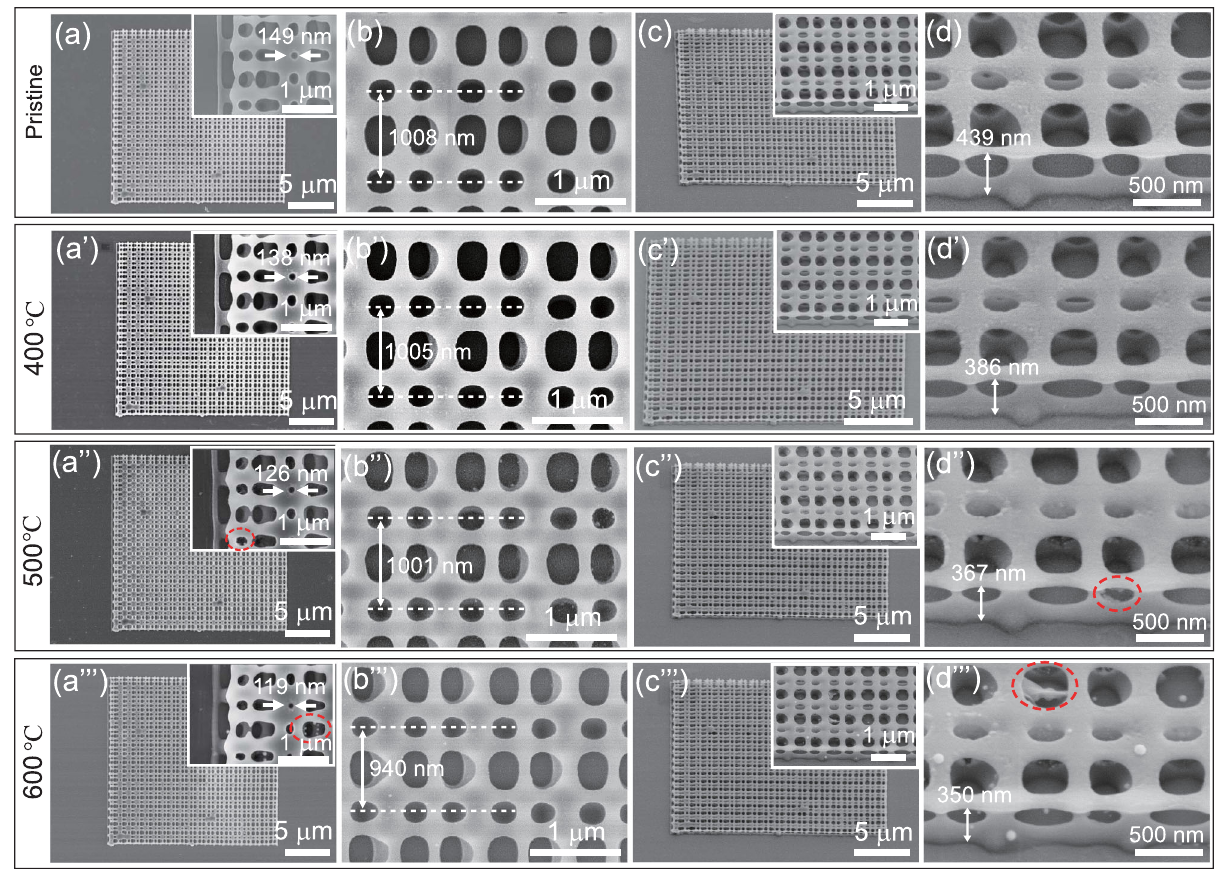
Fig. 5 SEM images of double layered grid HSQ microstructure by FsLDW before and after thermal treatment. a – d are SEM images of the HSQ microstructure before thermal treatment. a ′ – d ′ , a ″ – d ″ , and a ‴ – d ‴ are SEM images of the HSQ microstructure after thermal treatment at 400, 500, and 600 °C, respectively. The insets in a – a ‴ , c – c ‴ are the high-magni fi cation details. The red dashed circles point out the slight decomposition of the 3D HSQ microstructure.